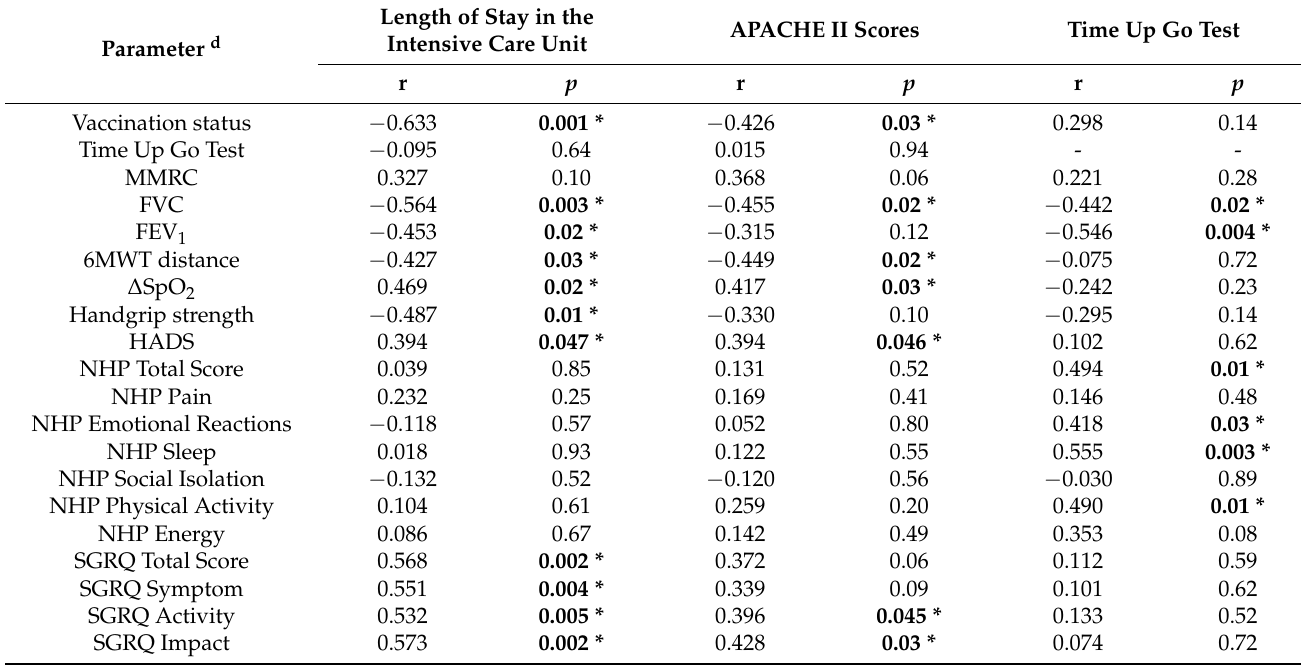
Table 4. Correlation of the length of stay in the intensive care unit and APACHE II scores of the individuals in the COVID-19 group with the measured